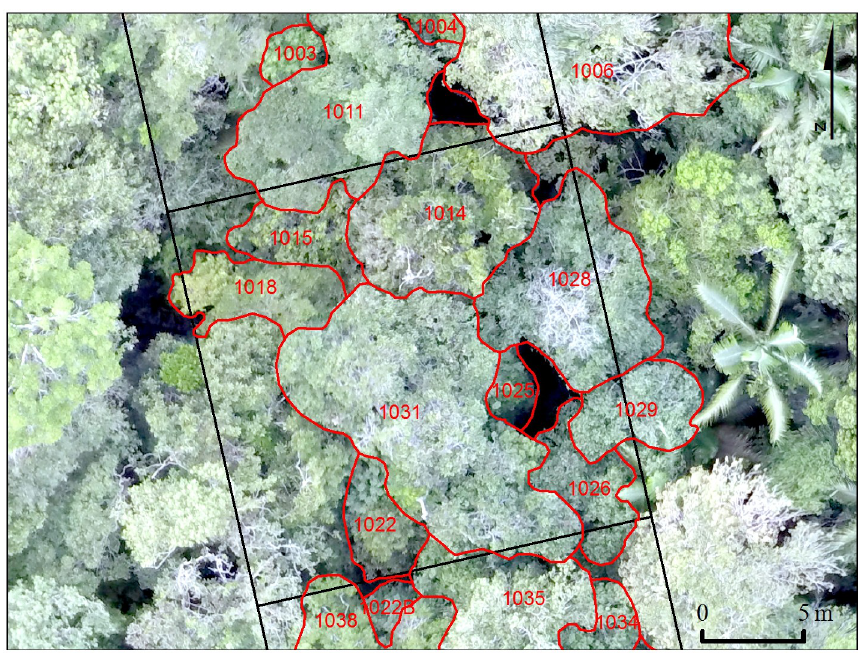
Fig 2. Orthomosaic image showing canopy tree crowns mapped in the field. Numbers in red are the assigned tree tags; the black lines correspond to the limits of each 20 m x 20 m subplots.